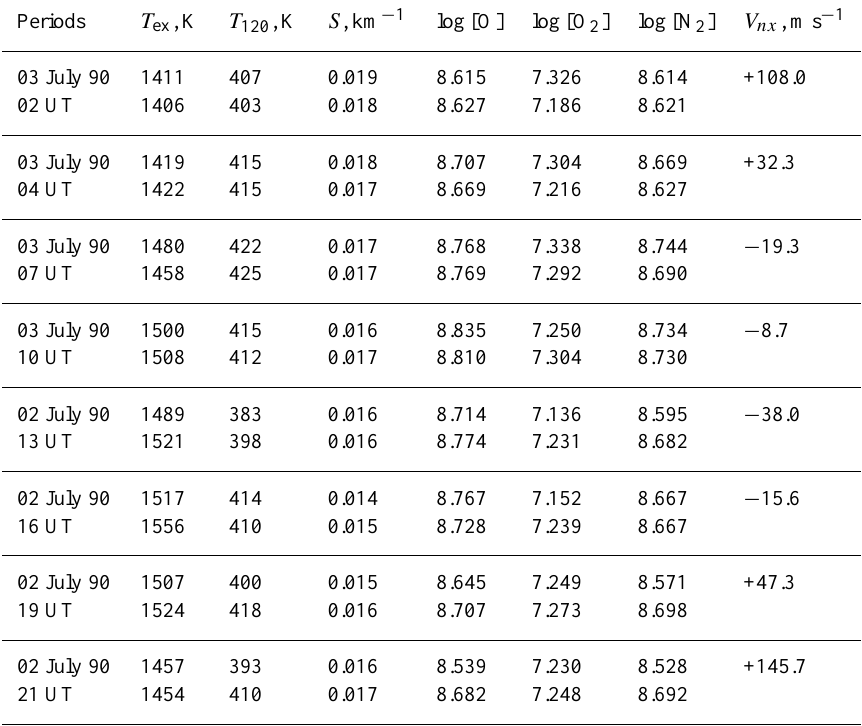
Table 2. Calculated thermospheric parameters in comparison with MSIS-83 values (second line). Concentrations and meridional winds are given at 300 km. Periods T ex , K T 120 , K S , km −